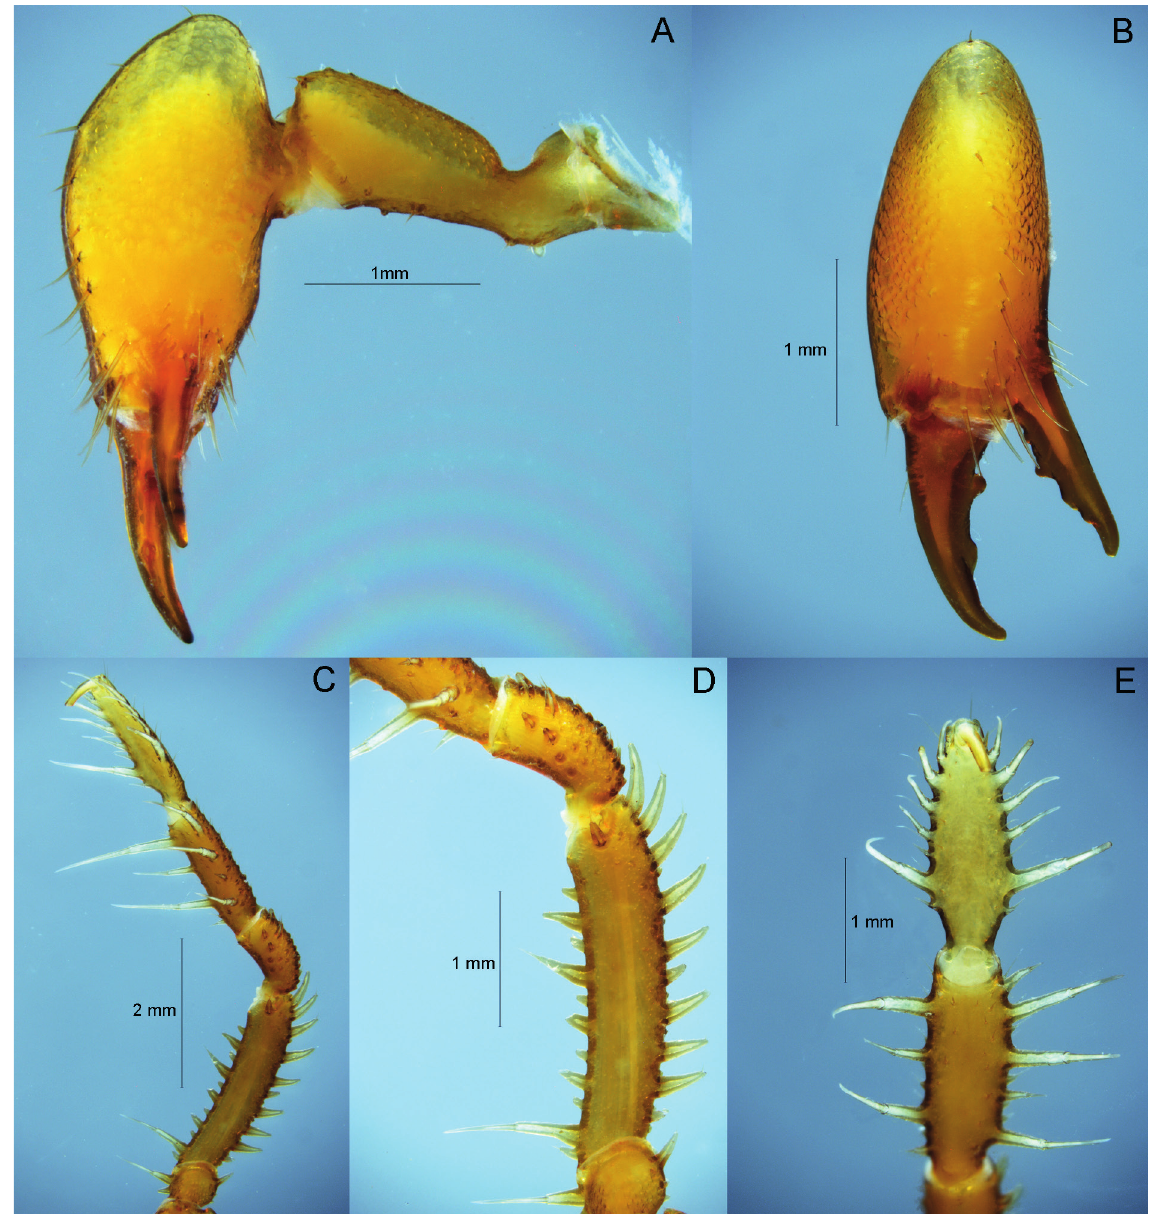
Fig. 5. Troglostygnopsis kalebi sp. nov., ♂, holotype (CNAN-T0850). A . Chelicera, mesal view. B . Chelicera, frontal view. C . Pedipalp, mesal view. D . Pedipalpal femur, mesal view. E . Pedipalpal tibia and tarsus, ventral